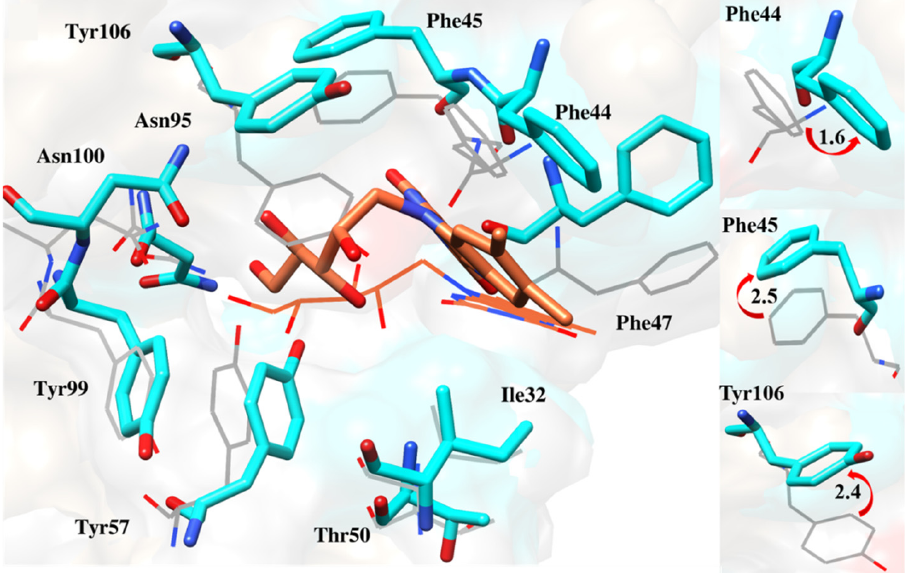
Figure 16. Orientation of Phe44, Phe45 and Tyr106 from MD simulation as compared to docking simulations [17].